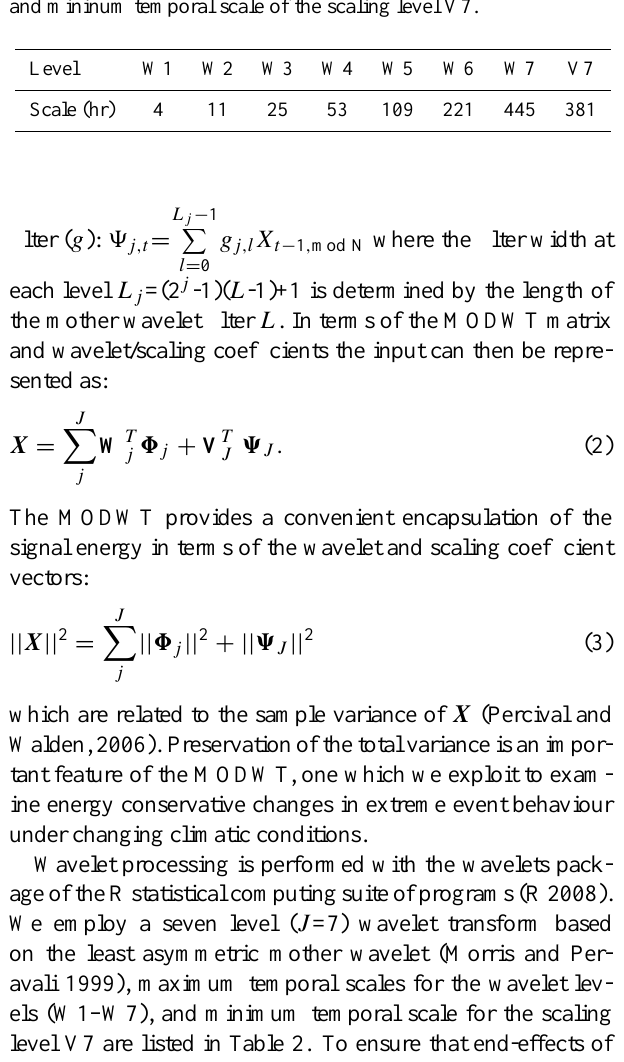
Table 2. Maximum temporal scale of each wavelet level (W1–W7), and mininum temporal scale of the scaling level